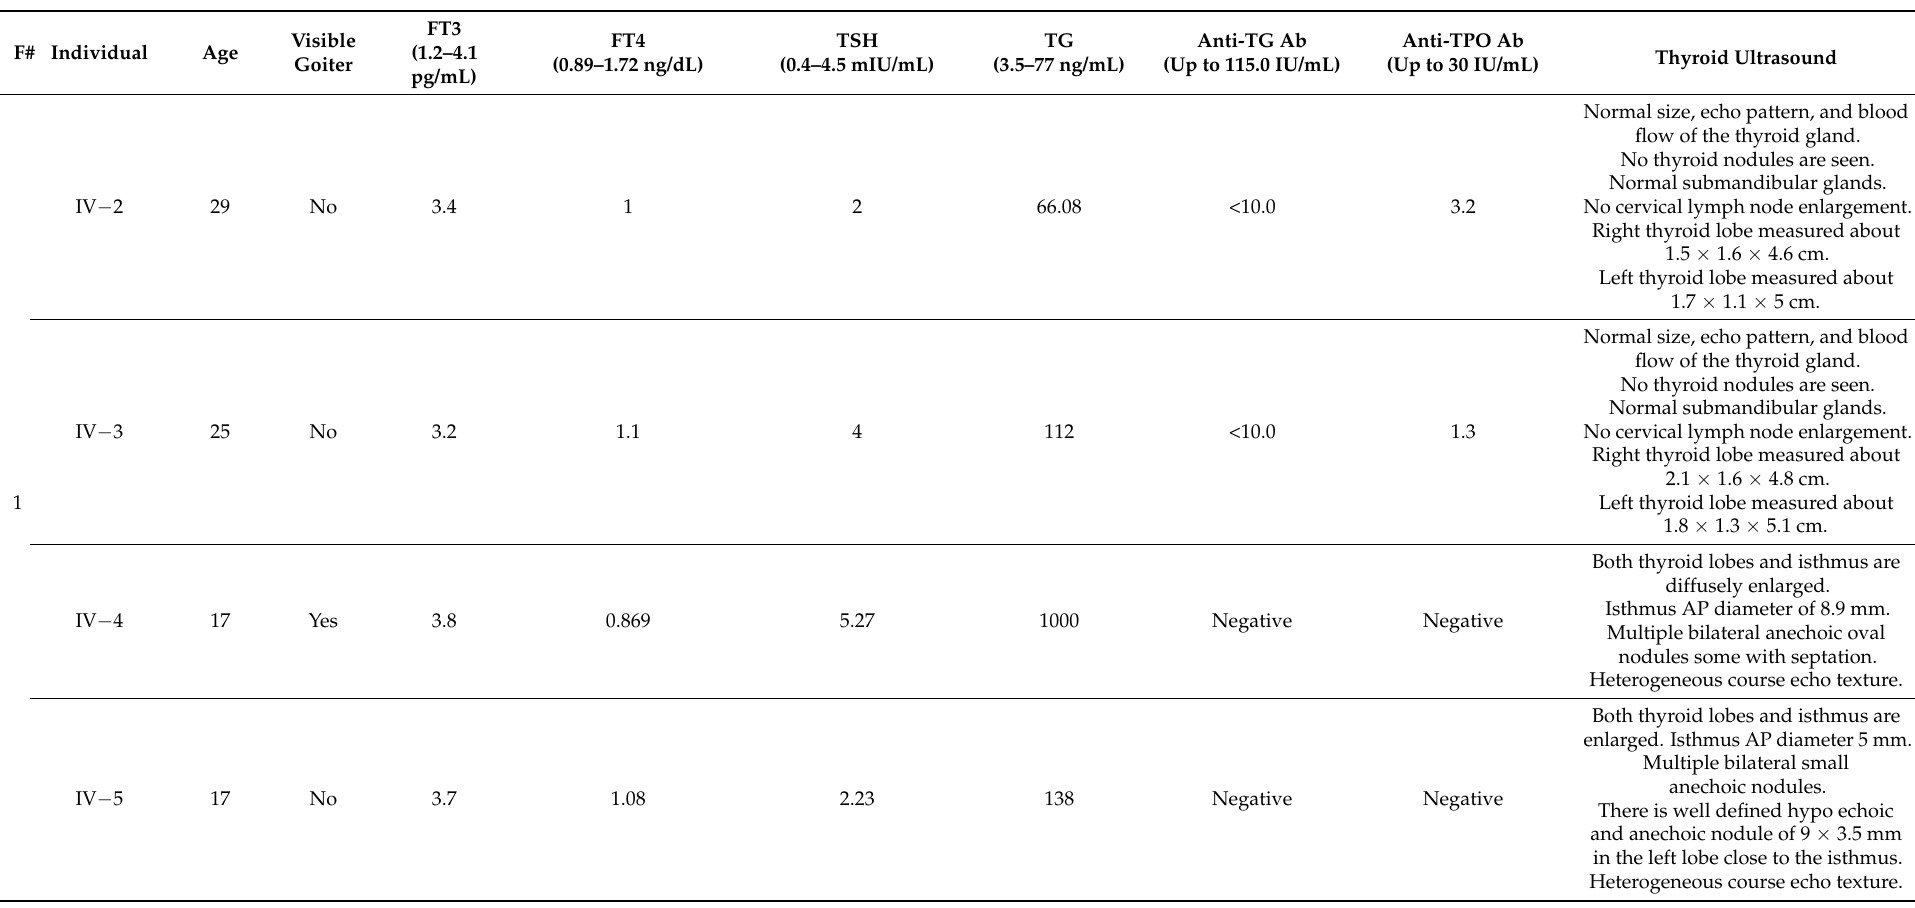
Table 3. Clinical characteristics and investigations of the thyroid